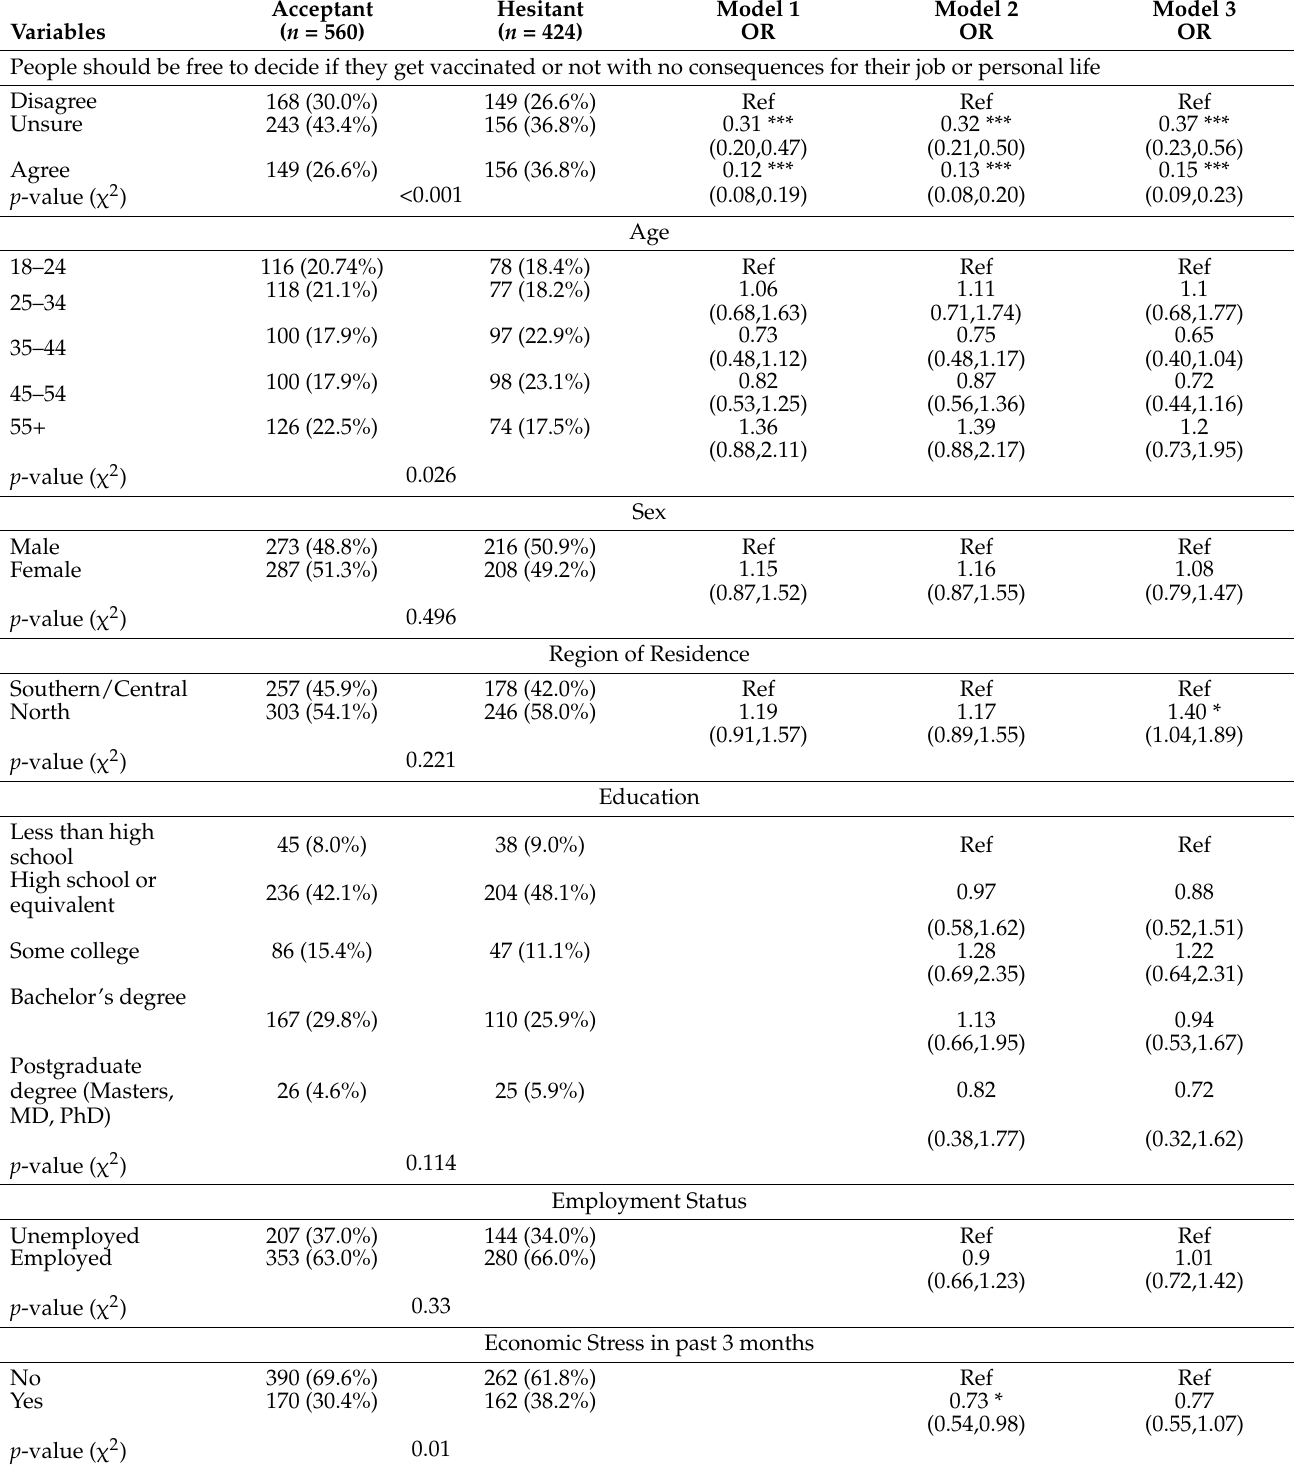
Table 2. Results of Chi-square analysis and logistic regression models. Outcome is vaccine acceptant (1) vs. hesitant